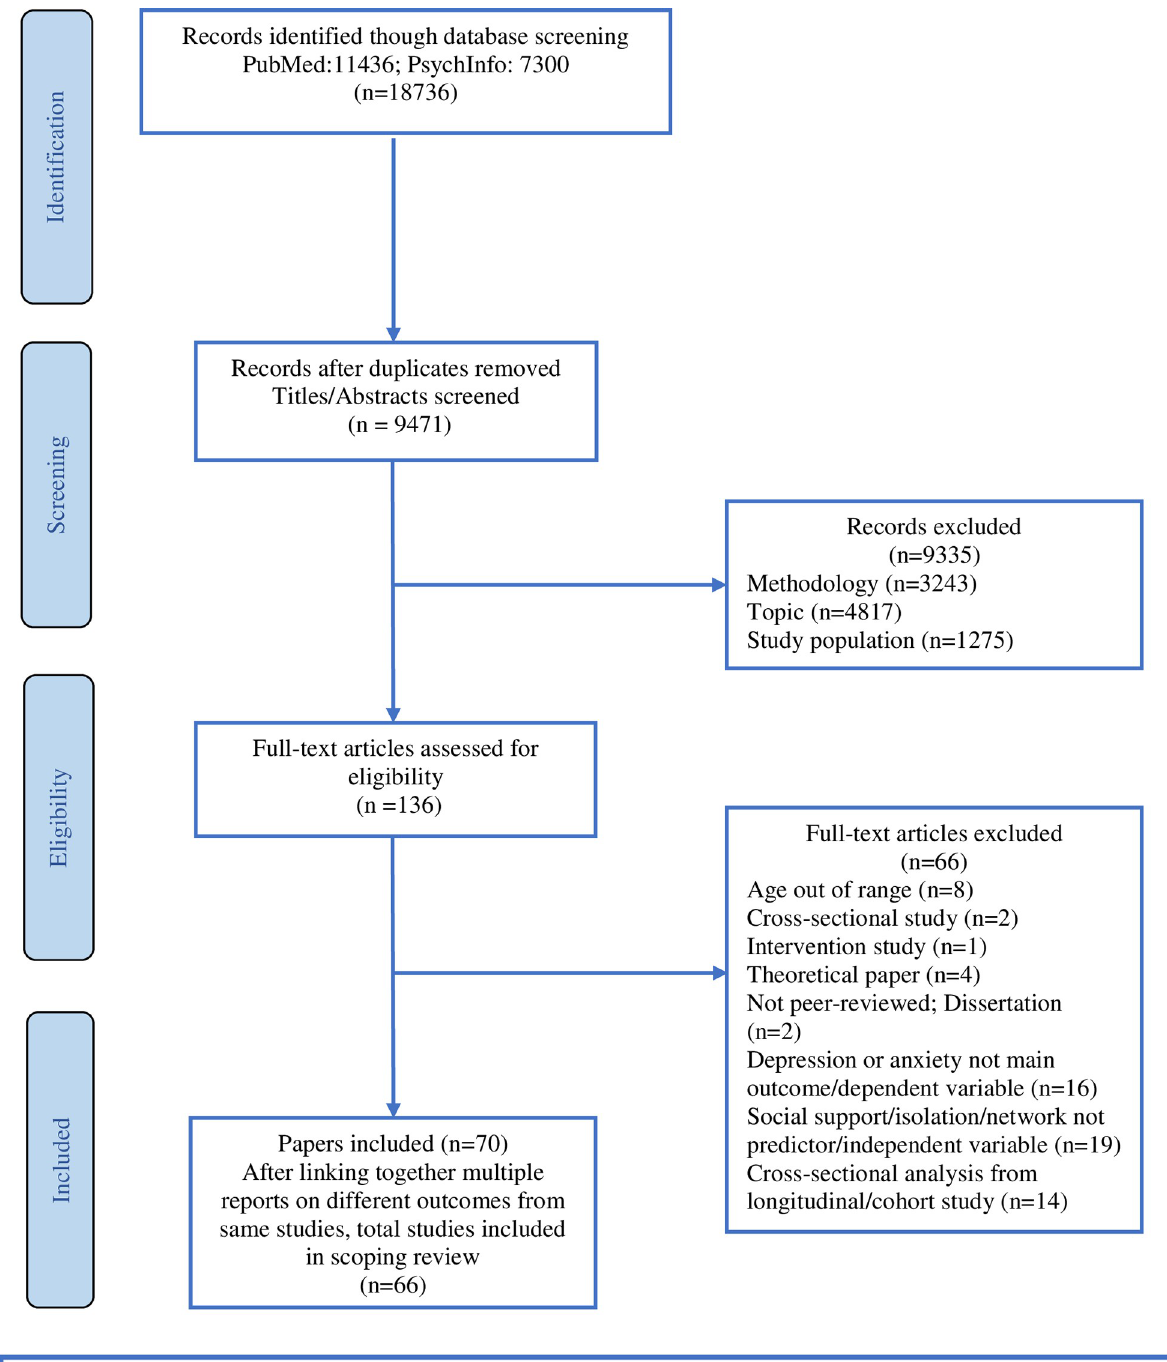
Fig 1. PRISMA flow chart of the scoping review. PRISMA diagram showing search and selection process of scoping review.